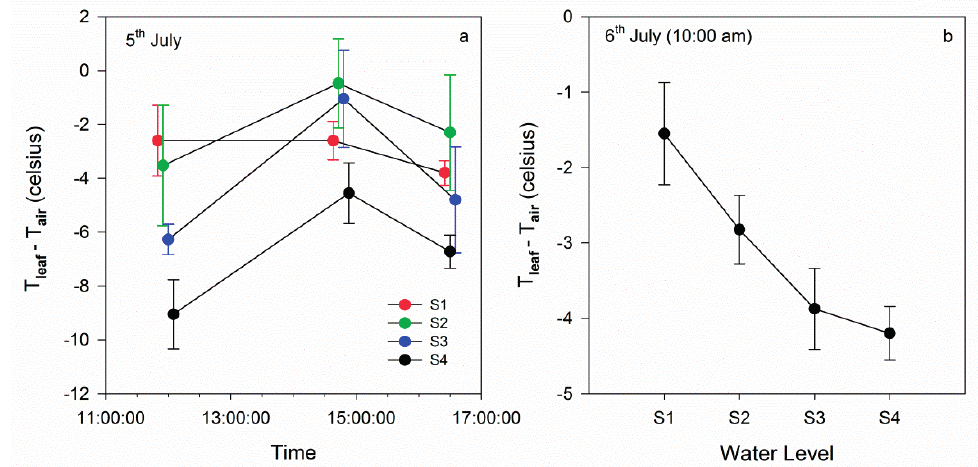
Figure 4. ( a ) Daily variations in T leaf -T air on 5 July. ( b ) Variations in T leaf -T air at 10:00 am on 6